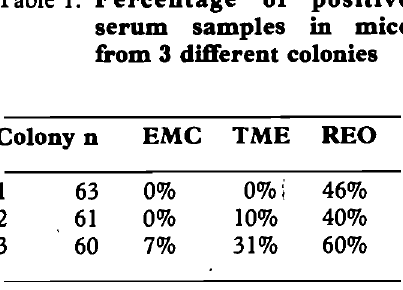
Table I: Percentage of positive serum samples in mice from 3 different